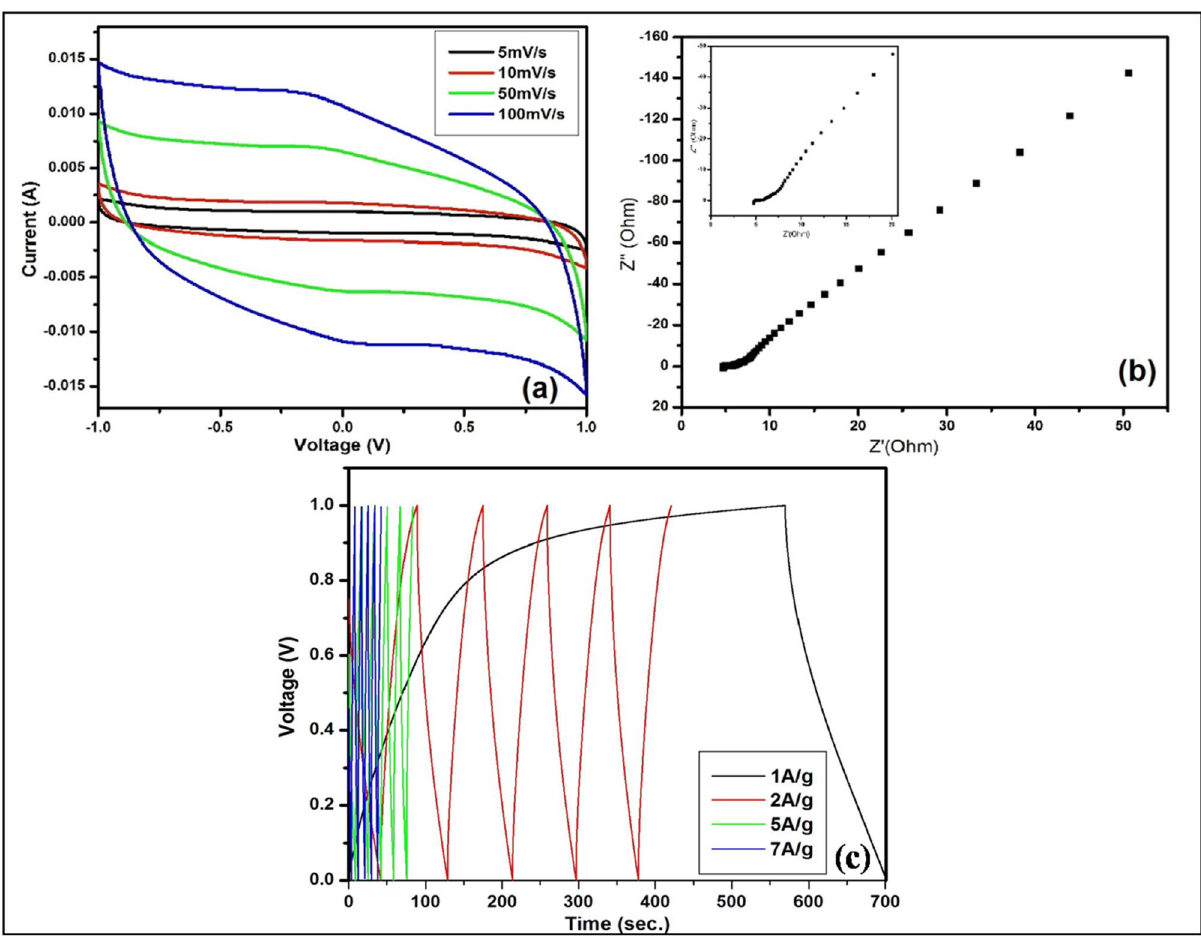
Figure 10. ( a ) CV curve ( b ) EIS spectra ( c ) GCD curve of the GNs based cell in 1 M H 3 PO 4 electrolyte.